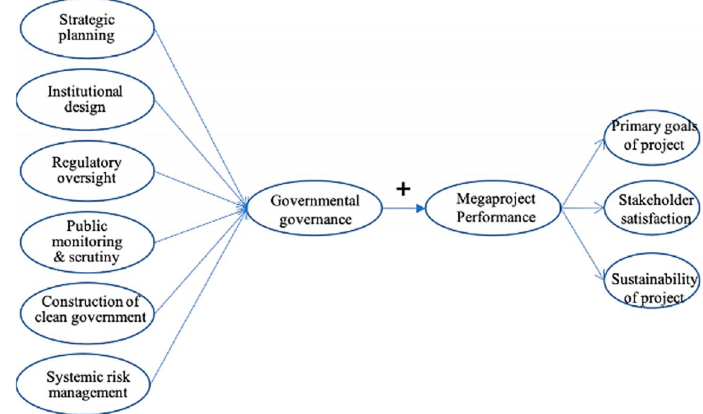
Figure 1. The hypothesized structural equation model of governmental governance and megaproject